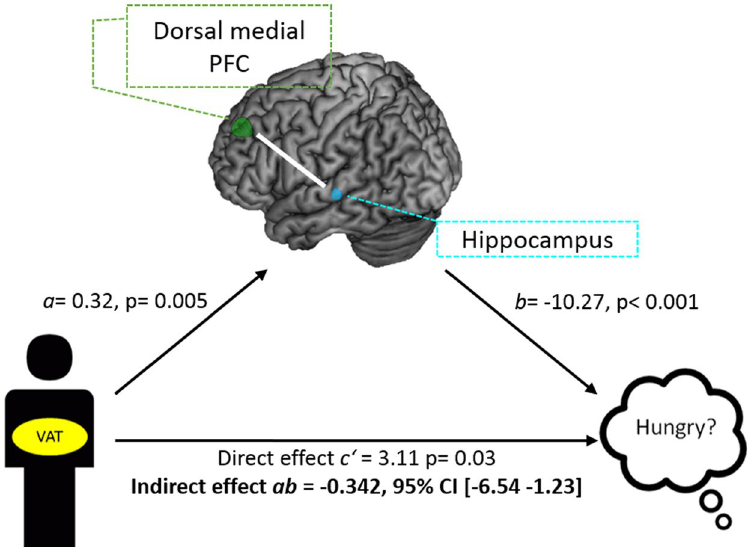
Figure 4. Model of visceral adipose tissue (VAT) as a predictor of subjective feeling of hunger mediated by functional connectivity change after insulin spray application. There is a significant indirect effect of VAT on the change of hunger via the change in functional connectivity between the dorsal medial prefrontal cortex and hippocampus 120 min after insulin. Path coefficients and corresponding p-values are shown next to arrows; path a indicates the relationship between VAT and insulin-induced hippocampus functional connectivity change, path b indicates the relationship between the insulin-induced hippocampus functional connectivity change and change in hunger; path ab indicates the indirect effect of VAT on hunger via the insulin-induced hippocampus functional connectivity change; path c’ indicate the direct effect of VAT on the change in hunger after